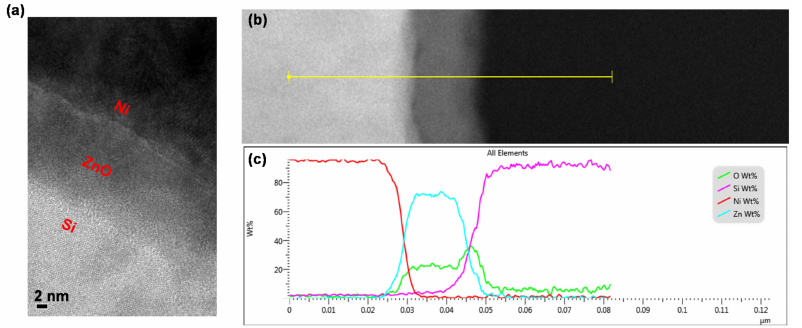
Figure 1. ( a ) TEM image, ( b ) STEM image, ( c ) EDS line scan of Ni/ZnO/Si memory device.